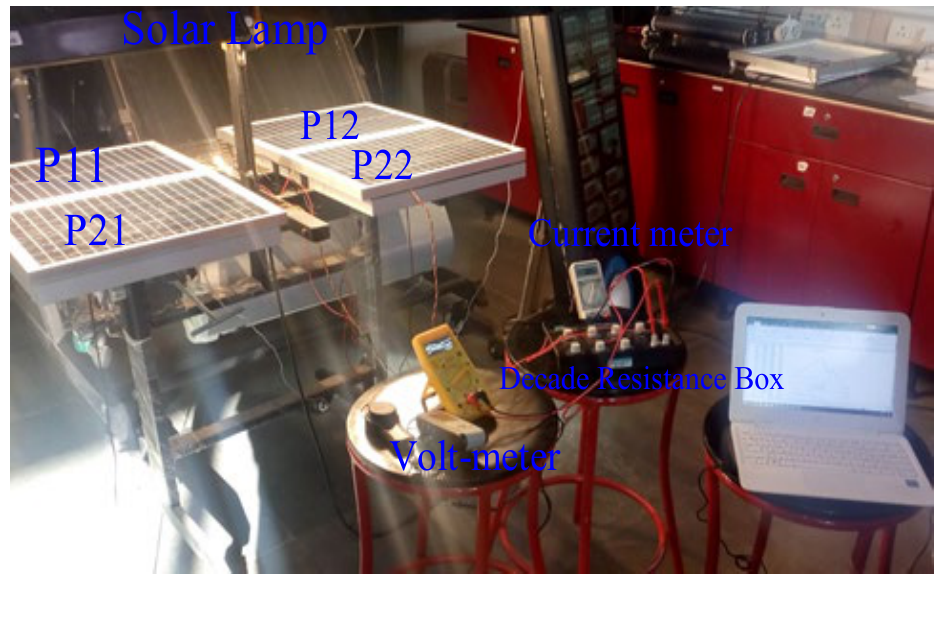
Figure 2. Experimental set-up